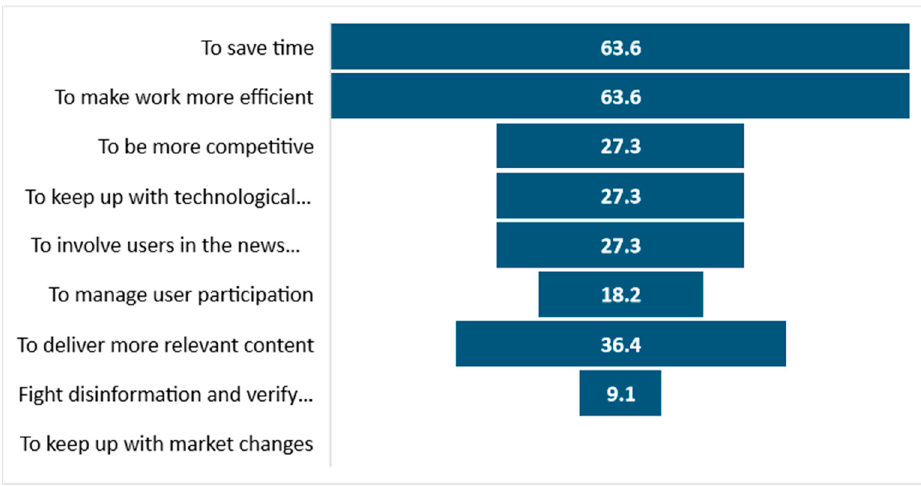
Figure 4. Reasons to the use of AI in the media. Journal. Media 2022 , 3 , FOR PEER REVIEW